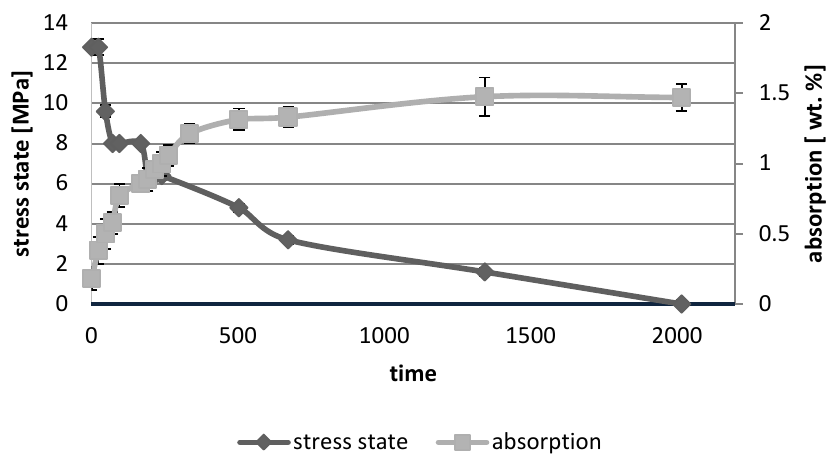
Figure 1. The relationship of absorption and stress state during water ageing (2016 h) of Beautifil Bulk Flow.